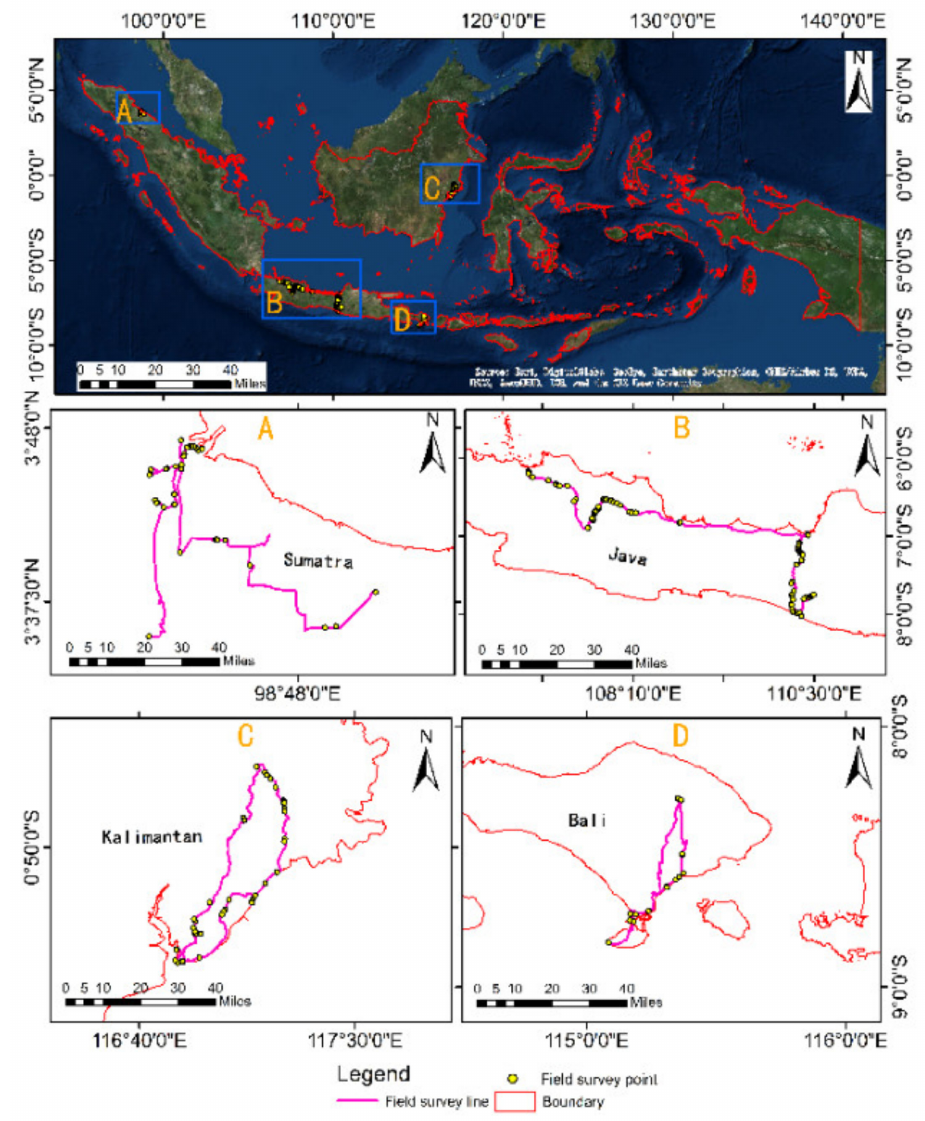
Figure 3. Spatial distribution of field survey sample points and